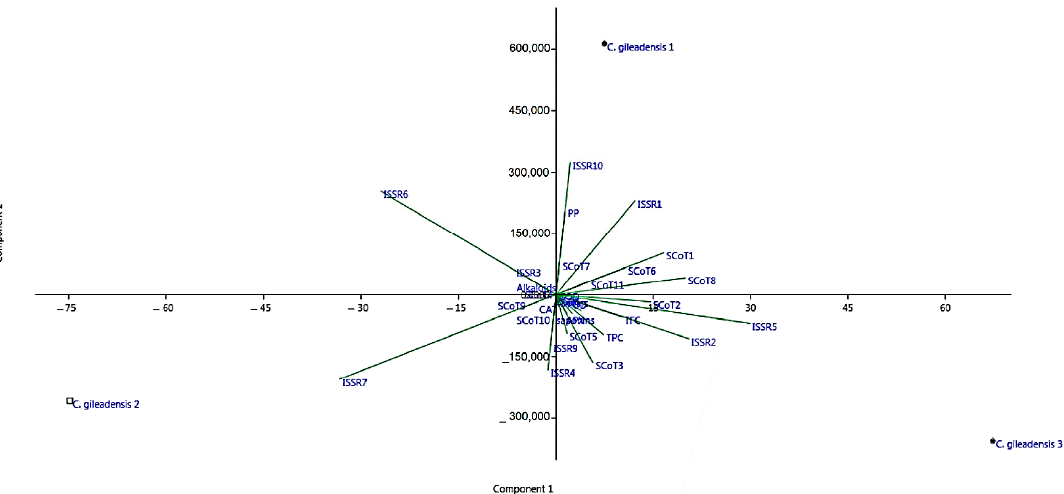
Figure 7. Principle component analysis (PCA) for all data attributes (phyto-biochenical parameters and molecular characteristics) for C. gileadensis accessions in KSA.